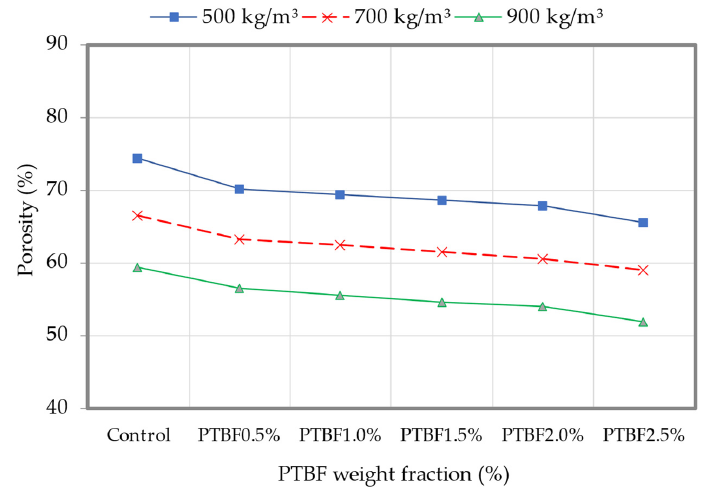
Figure 10. Porosity of LFC with different weight fractions of PTBF.